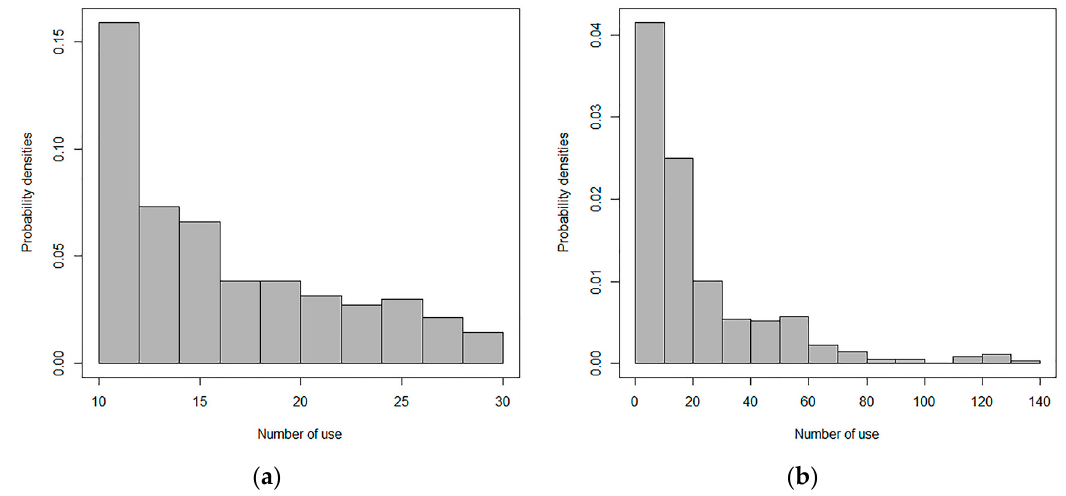
Figure 5. ( a ): Distribution of use frequency (first stage). ( b ): Distribution of use frequency (second stage).